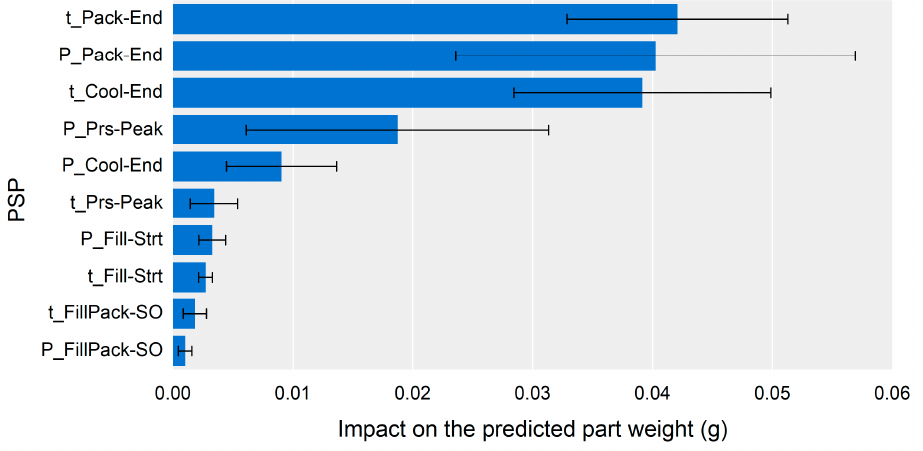
Figure 9. Impact of the PSPs to the part weight.